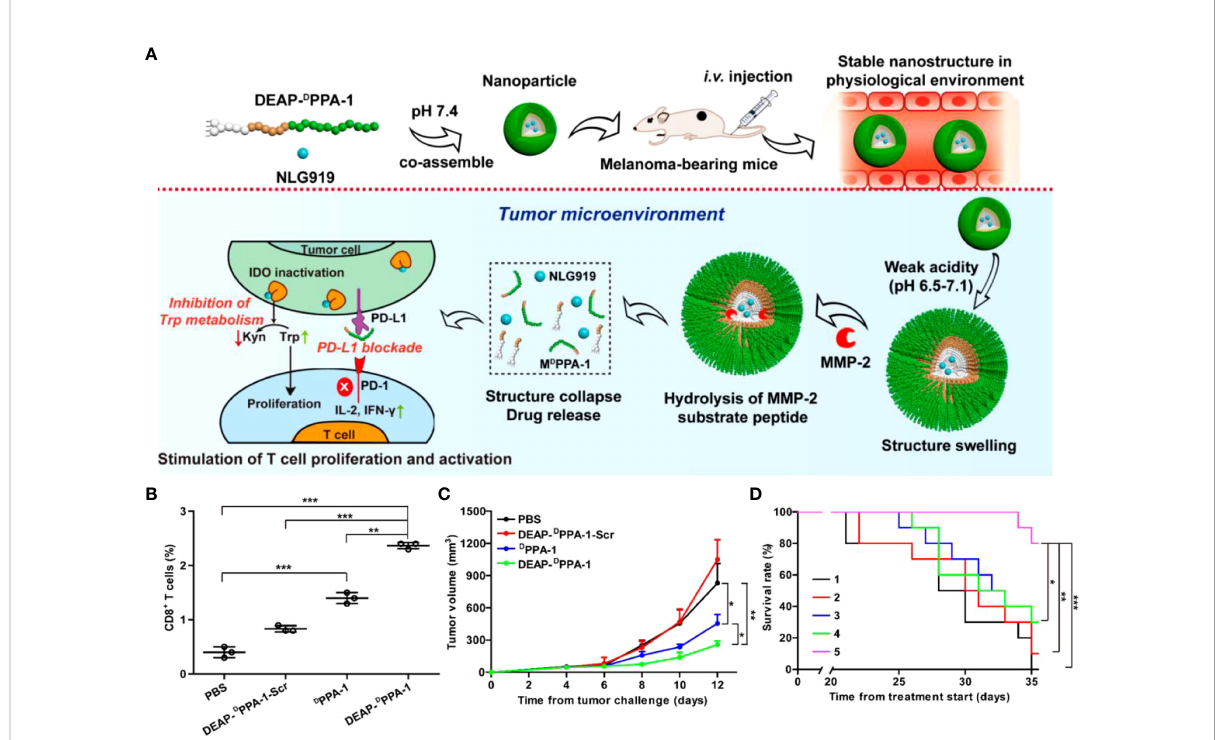
FIGURE 2 (A) . Schematic representation of NLG919@DEAP- D PPA-1 assembly in vitro and tumor immunotherapy in vivo . (B, C) Proportion of CD8 + T cells in tumor tissues and tumor volume in B16-F10 tumor-bearing mice after treatment with PBS, DEAP- D PPA-1-Scr, D PPA-1 and NLG919@DEAP- D PPA-1, respectively. (D) Survival experiment of B16-F10 tumor-bearing mice after treatment with different groups. Treatment groups: 1, DEAP- D PPA-1-Scr; 2, NLG919; 3, NLG919@DEAP- D PPA-1-Scr; 4, DEAP- D PPA-1; 5, NLG919@DEAP- D PPA-1 (*p < 0.05, **p < 0.01, ***p < 0.001) (47). Reprinted with permission from Ref. (47). Copyright© 2018, copyright Cheng et